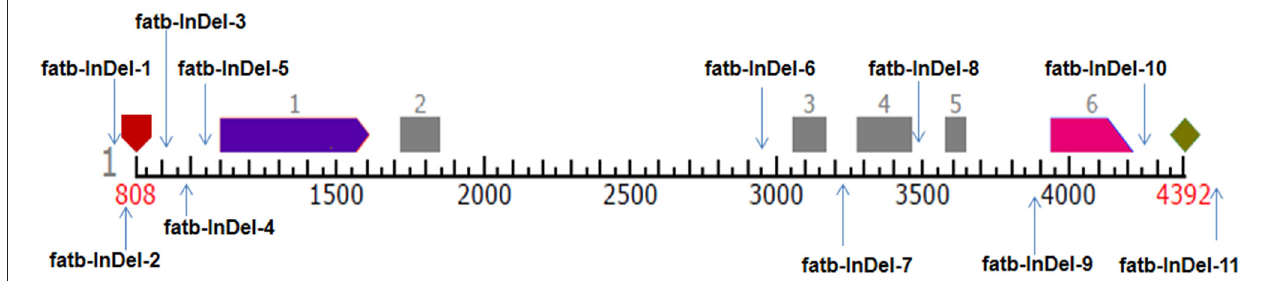
FIGURE 1 | Pictorial representation of InDel-based markers position in Zmfatb gene. Pentagon in maroon colour represents TSS and rhombus in light green colour represents polyA site; light purple and pink arrows represent first and last exons; grey boxes represent